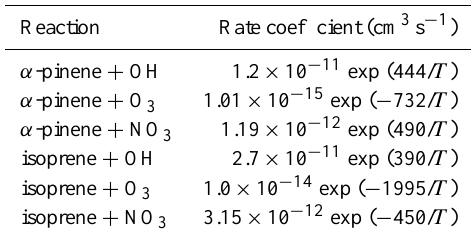
Table 1. BVOC reaction rates used in this study (Atkinson et al., 1989,